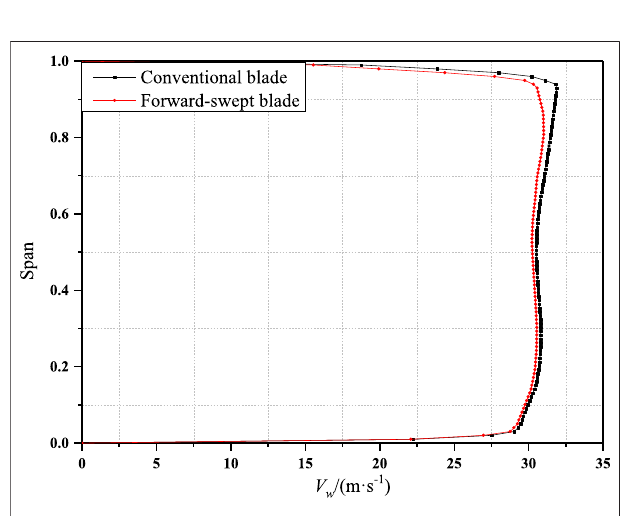
FIGURE 14 | Axial velocity comparison of forward-swept blades and conventional blades at the